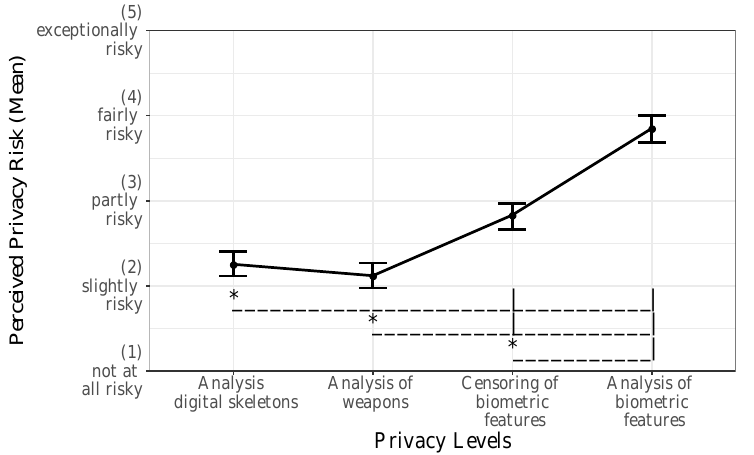
Figure 5. Privacy levels and perceived privacy risk. Note: Significant results are marked with asterisks (*), ρ ≤ 0.05. Standard error of means are